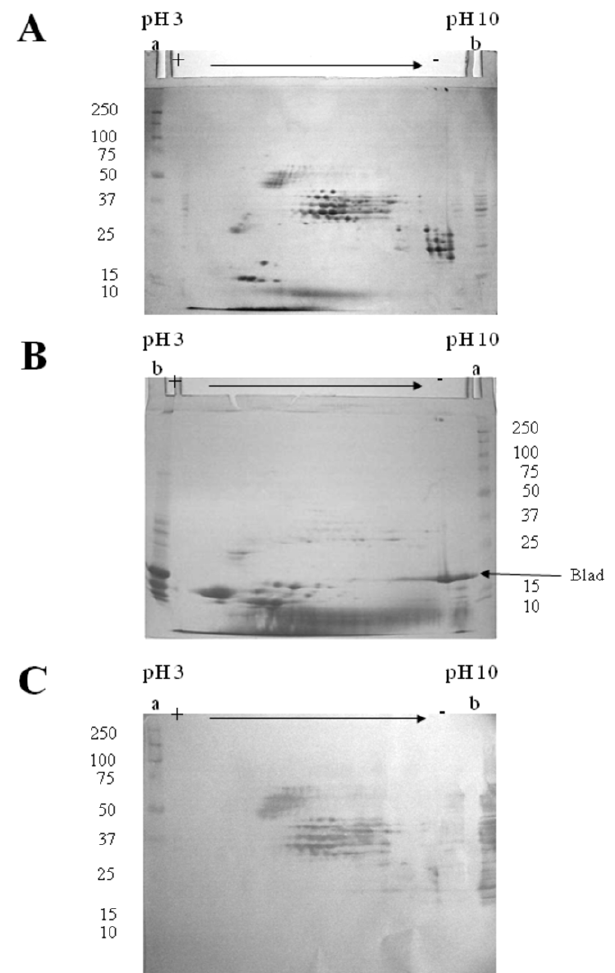
Figure 3. Two-dimensional, structural analysis of b -conglutin and blad from Lupinus albus . b -Conglutin (A,C) and the protein containing blad (B) were extracted, purified from the cotyledons of dry seeds and eight-days germinated seedlings, respectively, and subjected to two-dimensional electrophoresis. The gels were either stained for total protein (A,B) or transferred onto a membrane and probed with anti-blad antibodies (C). Two hundred m g of protein were used to prepare the 2D-gels (A,B) and 50 m g to prepare the 2D-blot (C). Lanes a: molecular mass standards (kDa) (precision protein standards prestained, broad range, Bio-Rad, in C). Lanes b: b -conglutin (A, 50 m g; C, 15 m g) or the native protein containing blad (B, 50 m g).